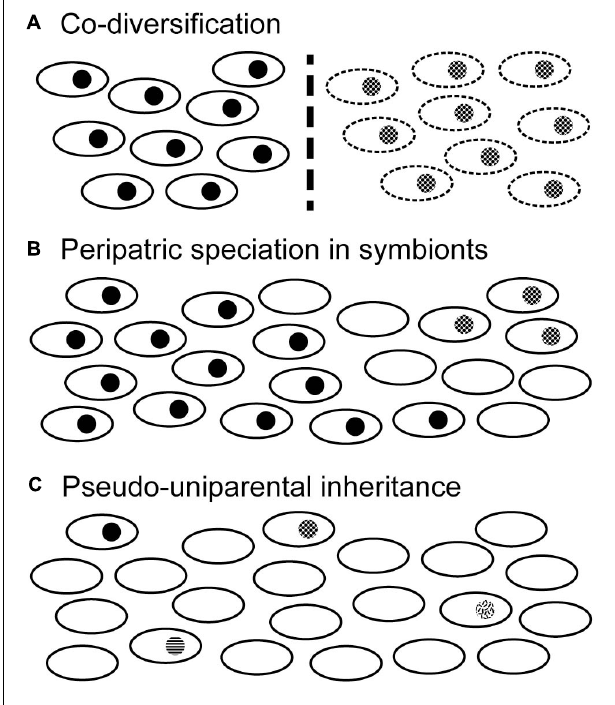
FIGURE 6 | Scenarios of evolutionary diversification in termite-specific protists. Open black ovals represent termite colonies while filled circles indicate one of their symbiotic protist species. Note that termite-specific protists are biparentally inherited and do not persist in the environment outside their hosts. (A) Co-diversification of host and symbiont species. If host populations become separated by some barrier to gene flow (dashed vertical line), symbiont populations will also be separated. Over time protists and hosts can co-speciate. (B) If certain host colonies lose the symbiont species (empty ovals), they can form a barrier isolating two populations of symbionts. Symbiont populations can then diverge from one another in the absence of host diversification. This might occur more readily on the margins of a host species’ range, in a process reminiscent of peripatric speciation. Note that other symbiont species occupying the same host species could remain unaffected. (C) If a symbiont species becomes rare due to loss from many host colonies, its inheritance becomes nearly uniparental: any host colony harboring that symbiont species would have inherited it from just one parent (i.e., king or queen), unless both parents came from the same colony. In this pseudo-uniparental inheritance scenario, symbiont genetic diversification is more likely to be congruent with that of the uniparentally inherited mitochondrial